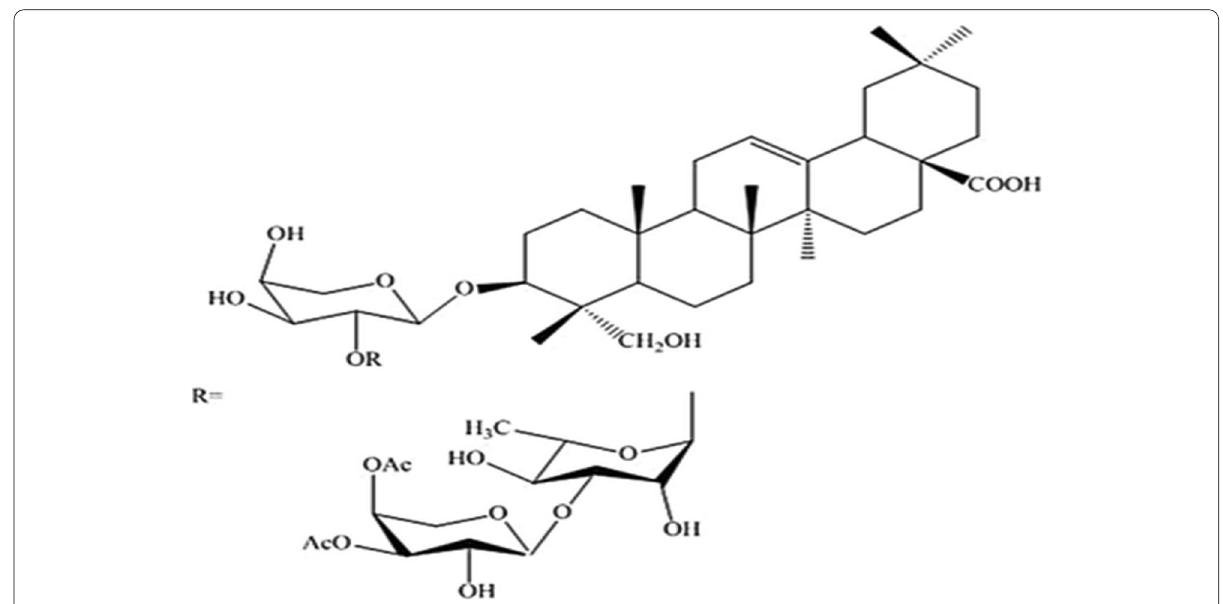
Fig. 1 Structure of Sapindus emerginatus (Triterpenoid